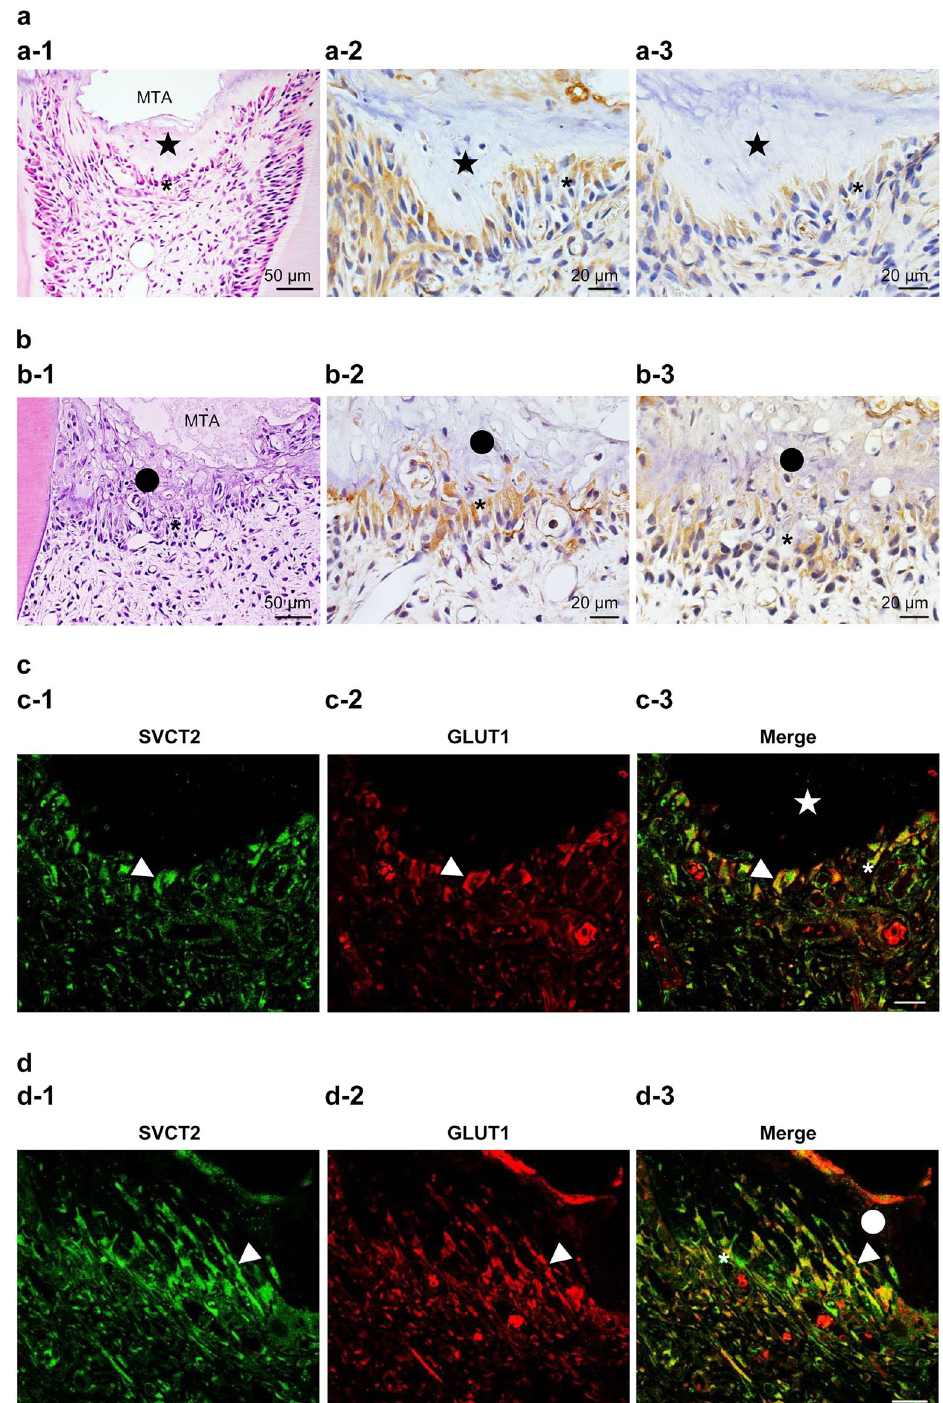
Figure 4. SVCT2 and GLUT1 are found with odontoblast-like cells in the pulp tissue of ODS rats after pulpotomy at 7 days followed by MTA capping. ( a and c ) ODS rats fed a normal diet (control; group 1). ( b and d ) ODS rats fed an ascorbic acid-free diet (group 2). (a-1 and b-1) Hematoxylin–eosin staining. Immunohistochemical staining of (a-2 and b-2) GLUT1 and (a-3 and b-3) SVCT2. (c and d) Double immunofluorescence staining of (c-1 and d-1, green) SVCT2 and (c-2 and d-2, red) GLUT1 in the cuboidal or columnar cells beneath the ( c ) reparative dentin or ( d ) necrotic layer. (c-3 and d-3) Merged images. The arrowheads indicate odontoblast-like cells that represented double positivity for SVCT2 and GLUT1. The closed star indicates the reparative dentin layer. The closed circle indicates the necrotic layer. The asterisks indicate the odontoblast-like cell layer. Scale = 20